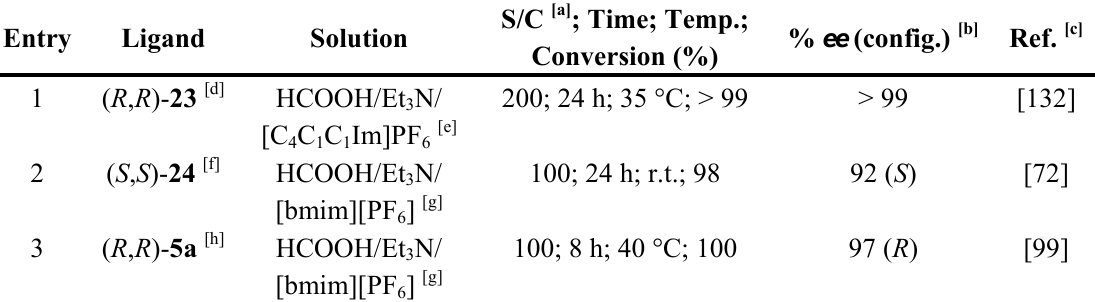
Table 7. ATH of acetophenone performed in ionic